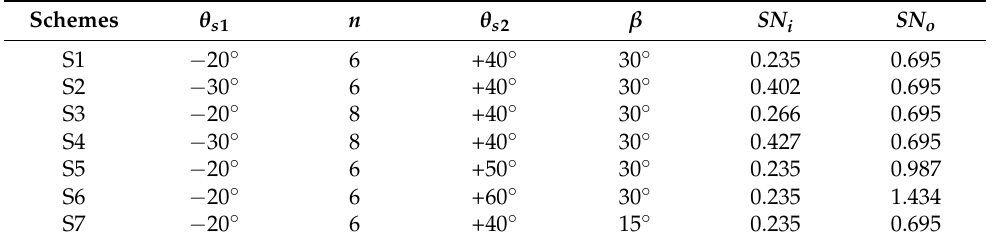
Table 1. Parameters of swirlers.